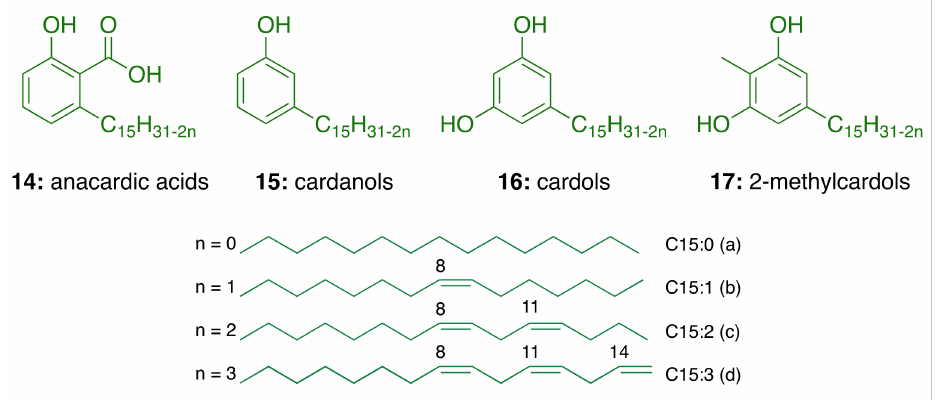
Figure 4. Chemical structures of CNSL phenolic